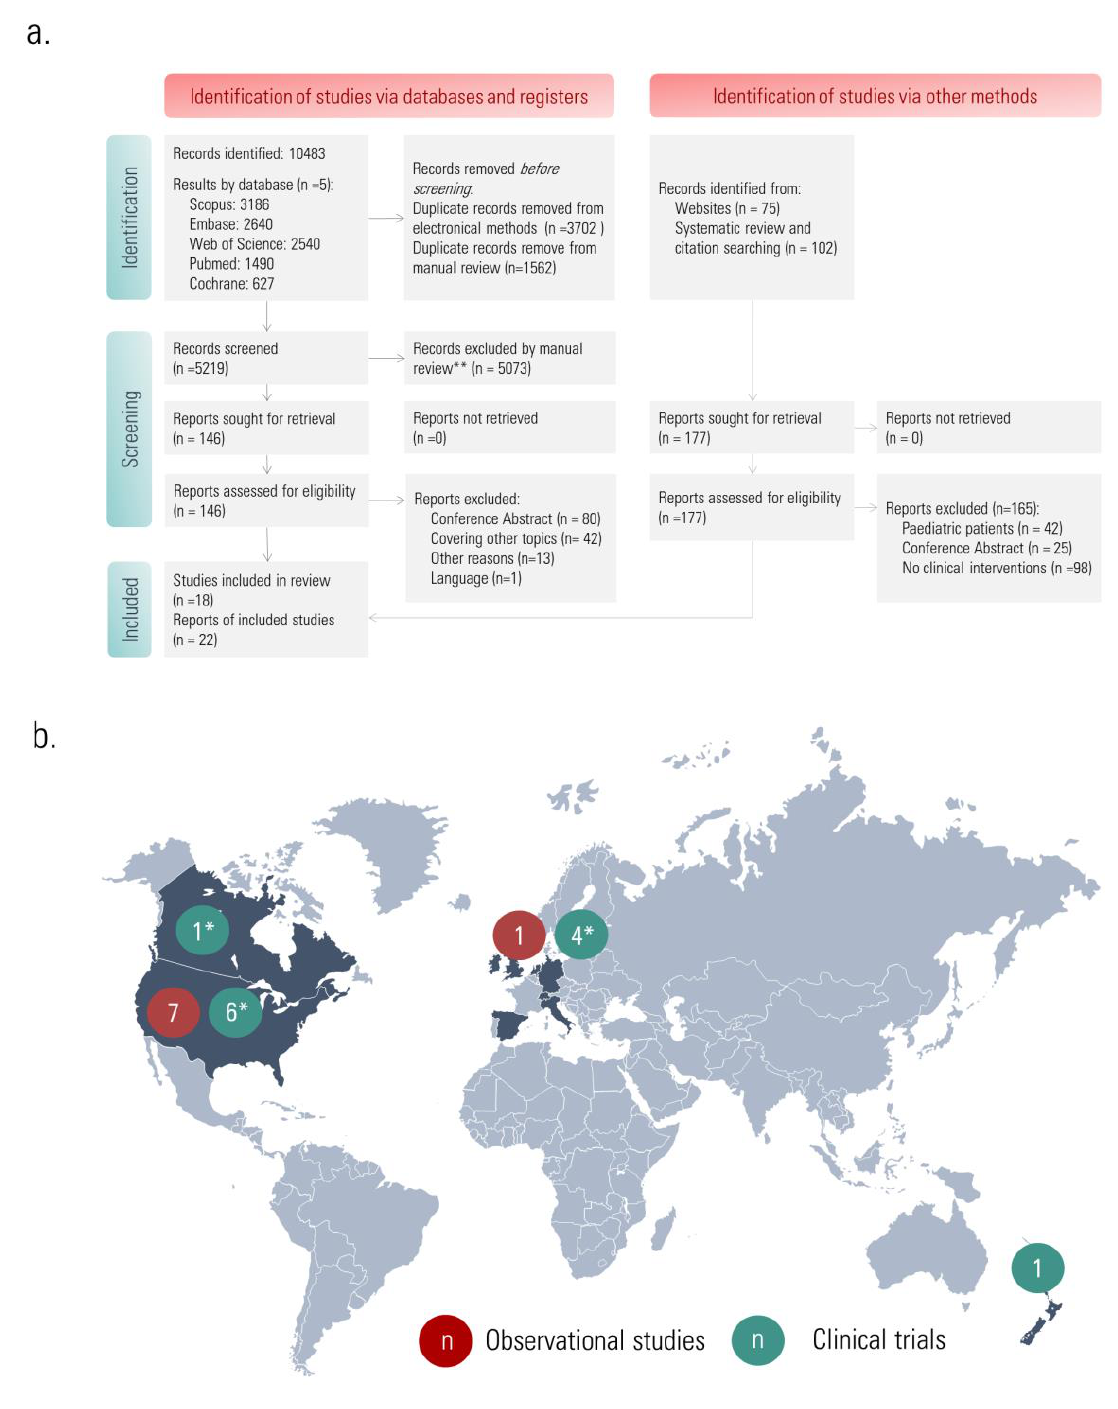
Figure 2. Search results. ( a ) PRISMA Flow Diagram; ( b ) distribution of studies by country. * One clinical trial was a multi-country study [51]: Canada, Germany, Italy, Netherlands, Spain, UK and the USA.